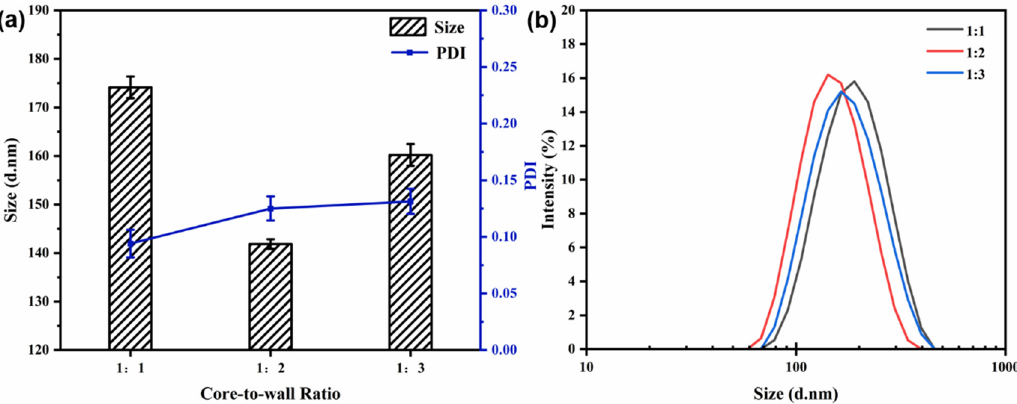
Figure 5. Effect of core-to-wall ratio on particle size and PDI ( a ) and size distribution ( b ) of nanocapsules.